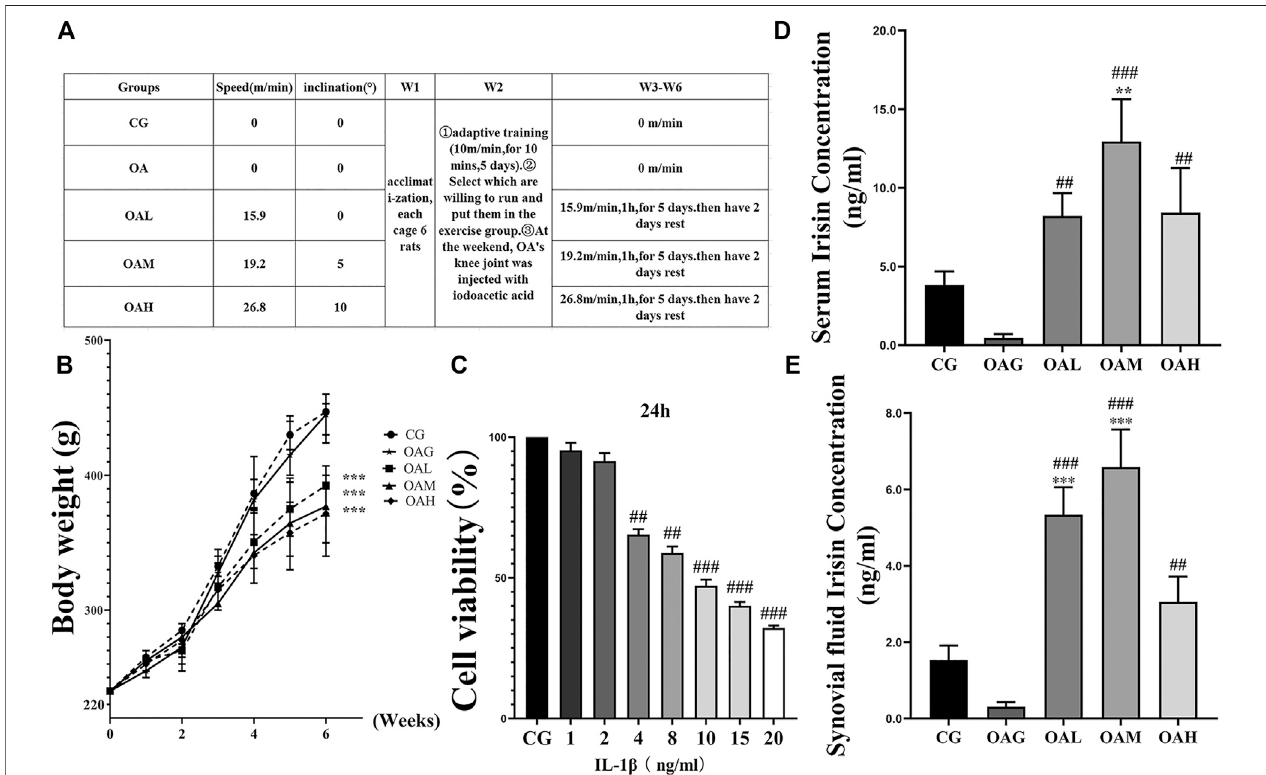
FIGURE2| TreadmillexerciseprotocolsestablishedfortheOAratmodelandELISAofserumandsynovial fl uidirisinconcentrationsinratsduringthestudyperiod. (A) The different intensities of treadmill exercise for OA rats were based on the following protocols: speeds of 15.9, 19.2, and 26.8 m/min with 0 ° , 5 ° , and 10 ° inclination represented the OAL, OAM, and OAH groups, respectively.CG and OAG were the sedentary groups. Adaptive feeding and training from week 1 to week 2; experiment protocols were implemented from week 3 to week 6. After the last exercise session, rats were immediately sacri fi ced. (B) Weight change in rats during the study period.Differences betweentreadmill exercise(OAL,OAM,and OAH)andsedentary(CGandOAG)groupsweresigni fi cant.Conversely, differencesamongOAL,OAM, and OAH were not signi fi cant; *** p < 0.001; n = 8 rats for each group. Data were expressed as the mean ± SEM. (C) The optimum applied concentration of IL-1 β in primary rat chondrocytes was evaluated using the CCK8 assay. The optimum applied concentration of IL-1 β in primary rat chondrocytes was 10 ng/ml. The serum (D) and synovial fl uid levels of irisin (E) in the treadmill exercise groups (OAL, OAM, and OAH) were higher than those in the sedentary groups (CG and OAG); those levels were especially higher in OAM. Values were expressed as the mean ± SEM. * p < 0.05 vs. CG; ** p < 0.01 vs . CG; *** p < 0.001 vs . CG. # p < 0.05 vs . OAG; ## p < 0.01 vs . OAG; ### p < 0.001 vs . OAG. n = 8, means ±95% CI.